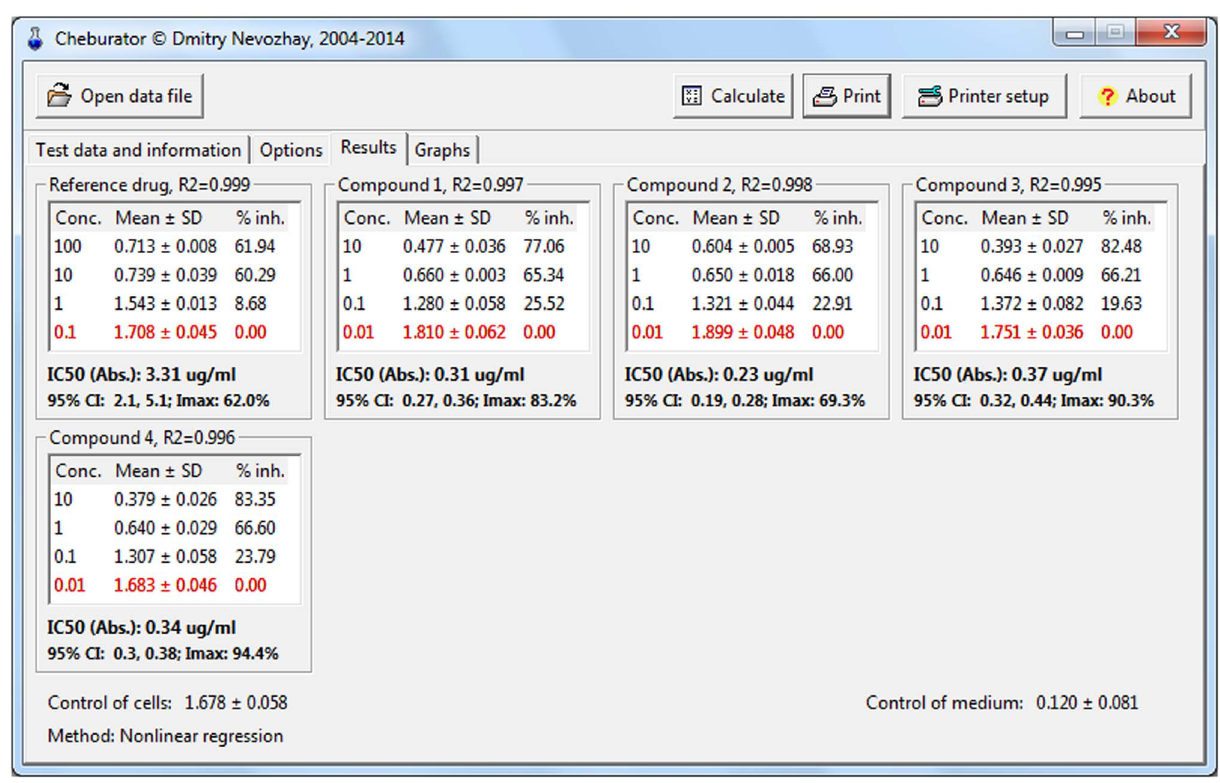
Figure 7. The Results tab after the analysis. It is showing the dose range applied, mean and standard deviations of absorbance values for every triplicate, calculated respective percentages of inhibition of cell proliferation, estimated IC 50 values, its type, method of calculation, and 95% confidence intervals (for regression analysis).